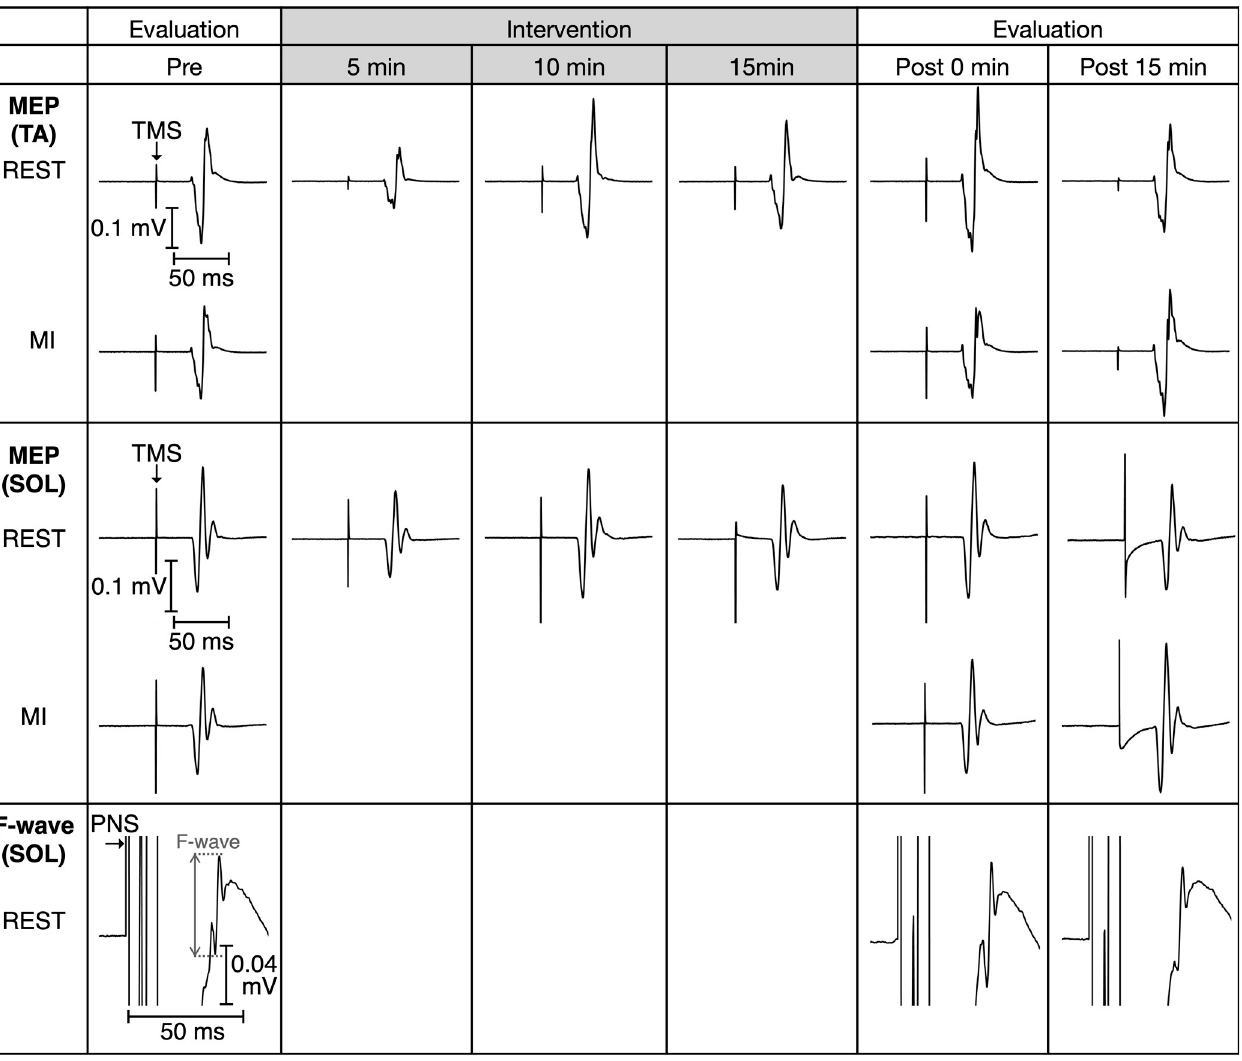
Fig 2. Example waveforms of motor evoked potential and F-wave recorded from one participant. The figure depicts mean motor evoked potential (MEP) waveforms in the tibialis anterior (TA) and soleus (SOL) muscles recorded before intervention, 0 min, and 15 min after the intervention in the REST and MI conditions. The mean MEP waveforms in the TA and SOL muscles in the REST condition are recorded during the intervention (i.e., after the first block [5 min], second block [10 min], and third block [15 min]). The mean waveforms of the F-wave in the SOL muscle recorded before intervention, 0 min, and 15 min after the intervention in the REST condition are